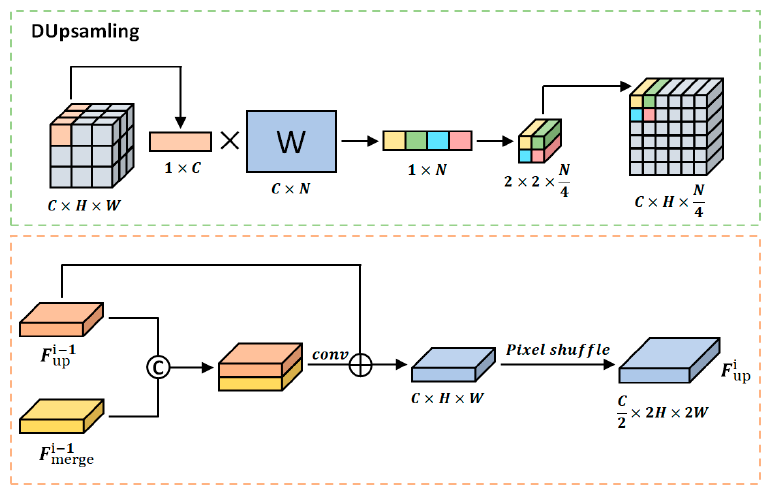
Figure 6. Decoder-related details (including composition of DUpsamling and steps after feature fusion).